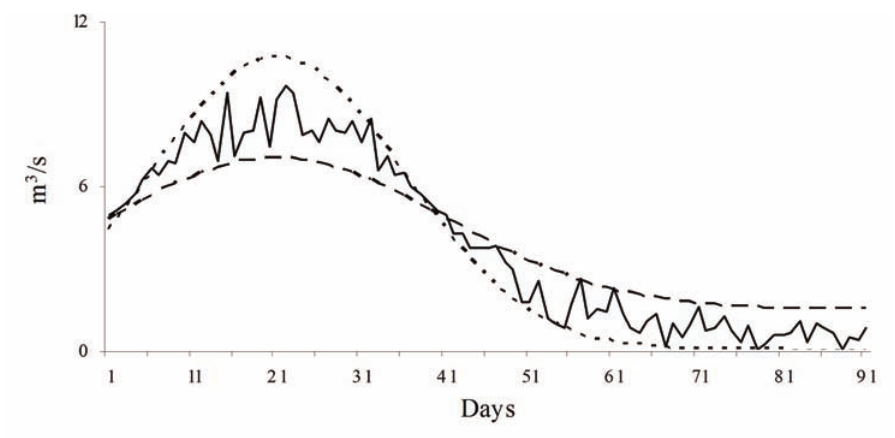
Figure 4. Example of the representative evolution of the effusion rate during a typical Etnean eruption, for an event lasting 90 days, with a peak effusion rate of ca. 10 m 3 s −1 located at ca. 1/3 of the overall duration, and with ca. 1/3 of the maximum value reached at ca. 2/3 of the duration. Note that the trend was obtained by uniting randomly chosen points between two Gaussian curves (dotted/dashed lines).